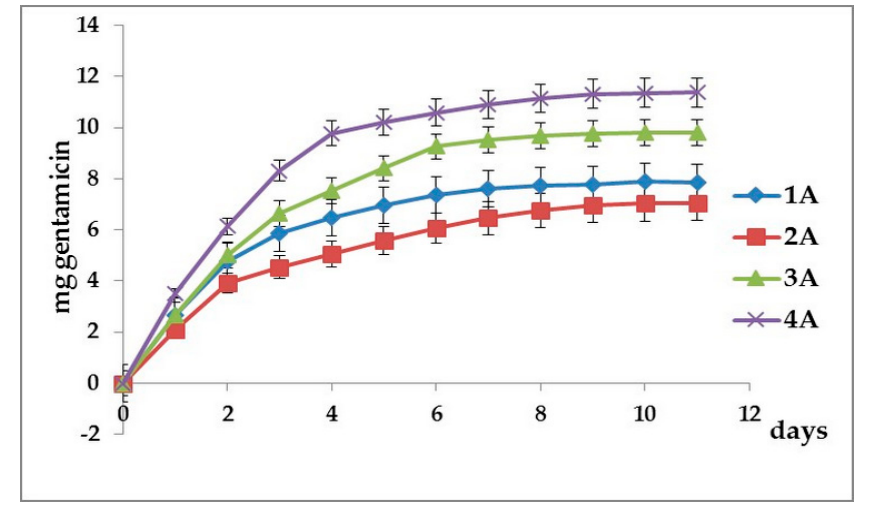
Figure 4. Cumulative amount of gentamicin released over time from samples 1A–4A.